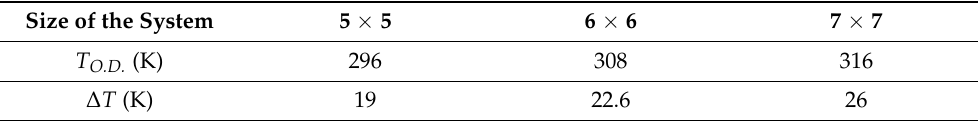
Table 1. Evolution of the order-disorder temperature T O.D. and ∆ T as a function of the size of the 2D system corresponding to Figure 1. The computational parameters are: ∆ / k B = 1300 K, L / k B = 0 K, G / k B = 172 K, J bb / k B = 60 K, J ss / k B = 50 K, J bs / k B = 20 K and ln( g ) = 6.01. For T O.D. , the values ∆ / k B = 0 K and ln( g ) = 0 are